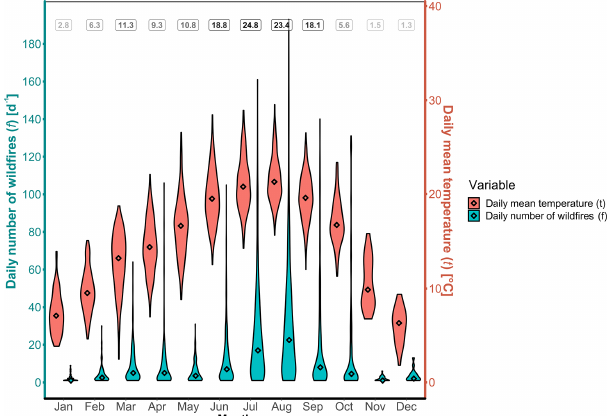
Figure 12. Violin plot of those days with both daily mean tempera- ture (red, upper violin plots) t and daily number of wildfires (blue, lower violin plots) f ≥ 1 fired − 1 , by month for the period 1980– 2005 in Porto District (Portugal). Only those wildfires with burned area A F ≥ 0 . 1 ha are included. Diamonds for both temperature and wildfires represent the median of all values in that month over the period of record. Numbers at the top of the graph represent the av- erage number of days per month where there are recorded both a temperature value t and at least one wildfire ( f ≥ 1 fired − 1 ). Daily mean temperature data from E-OBS (Cornes et al., 2018) and wild- fire data from Pereira et al. ( 2011).